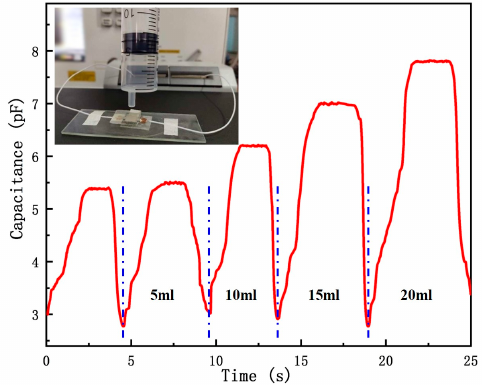
Figure 10. Test of non-contact information by flexible pressure sensing structure.